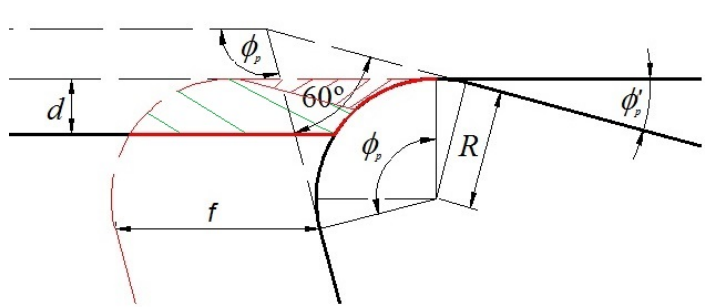
Figure 1. Sketch of the geometry of the turning process, initial chip section and non-machined zone for low values of feed.